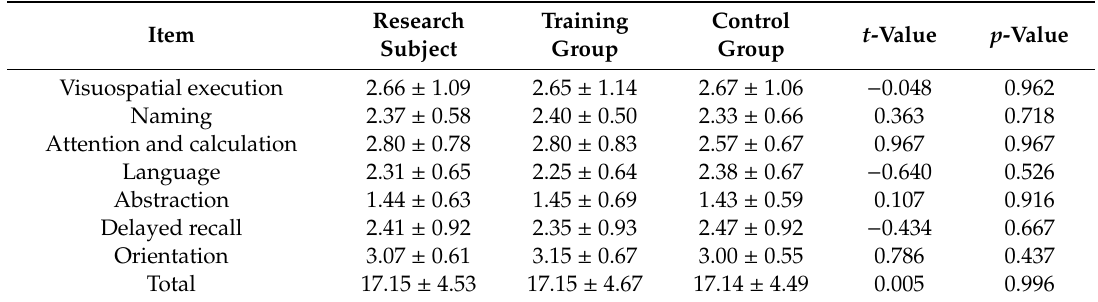
Table 9. Baseline cognition level ( N = 41 and X ± SD).